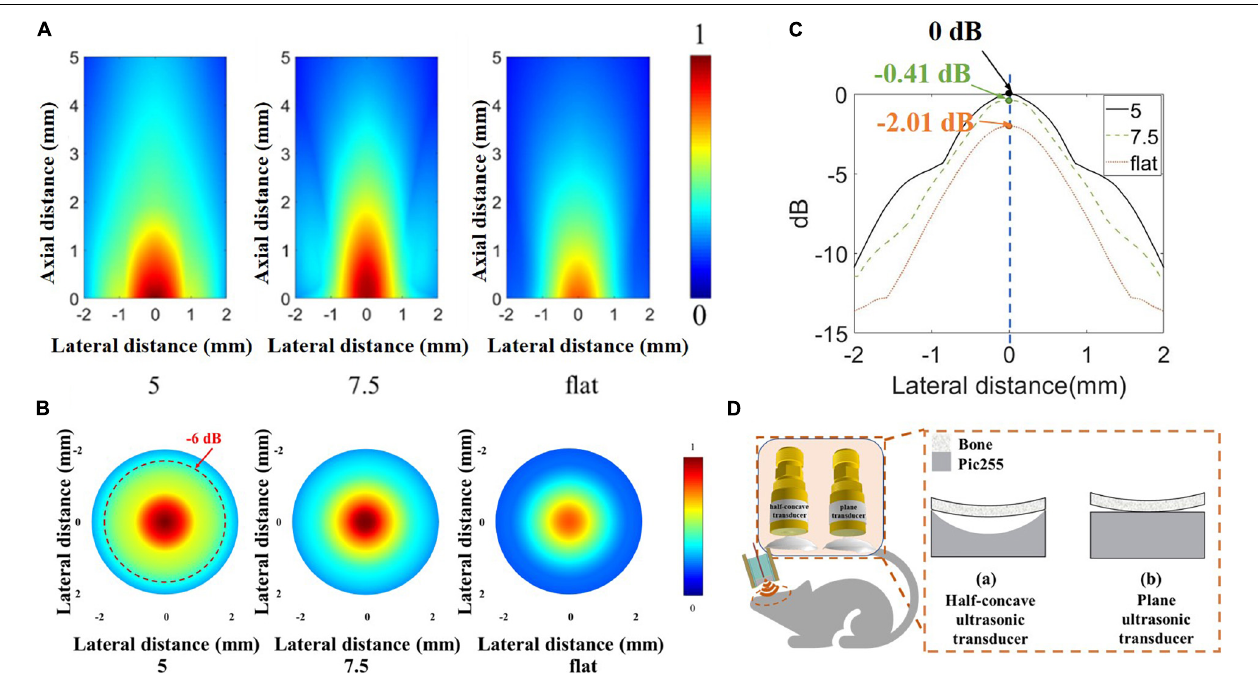
FIGURE 8 | (A) Normalized acoustic field after transmitting through the skull by simulation. (B) Normalized lateral acoustic field distribution of different transducers by simulation at a maximum acoustic pressure point. (C) The normalized acoustic pressure distribution of the focal area in the X-Y plane. (D) The relative position of the skull and different transducers.